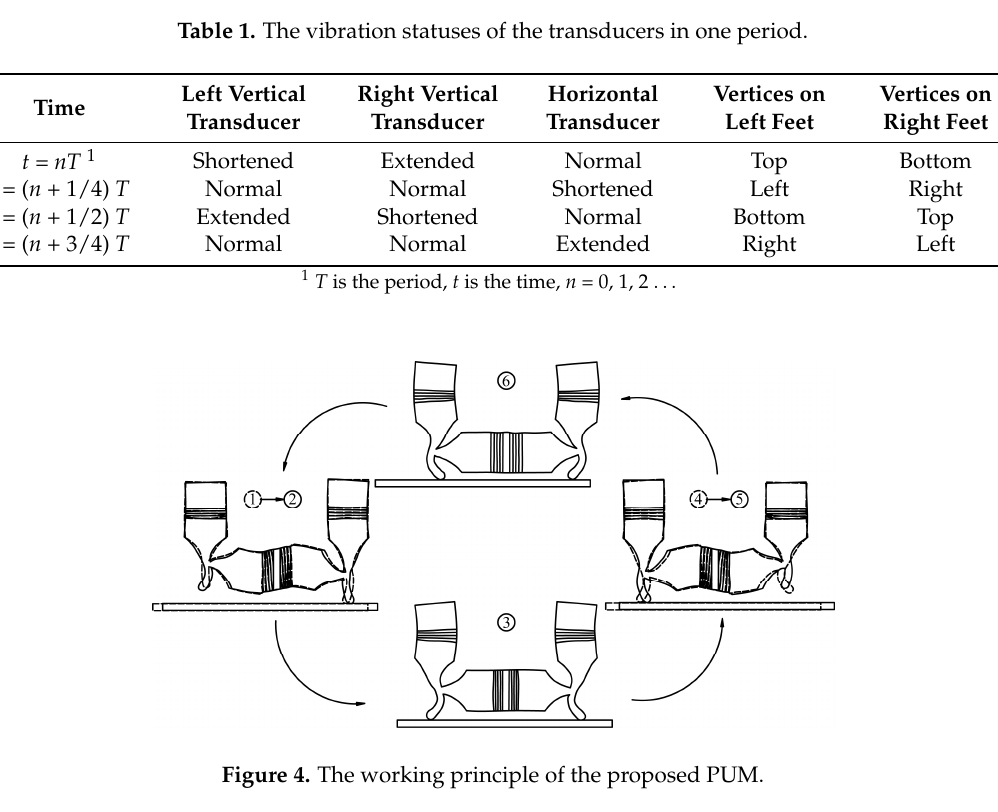
Table 1. The vibration statuses of the transducers in one period.